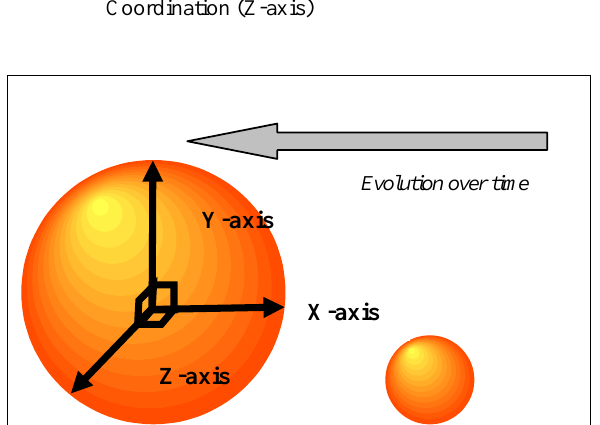
Figure 3 – Three faceted collaborative model (evolving